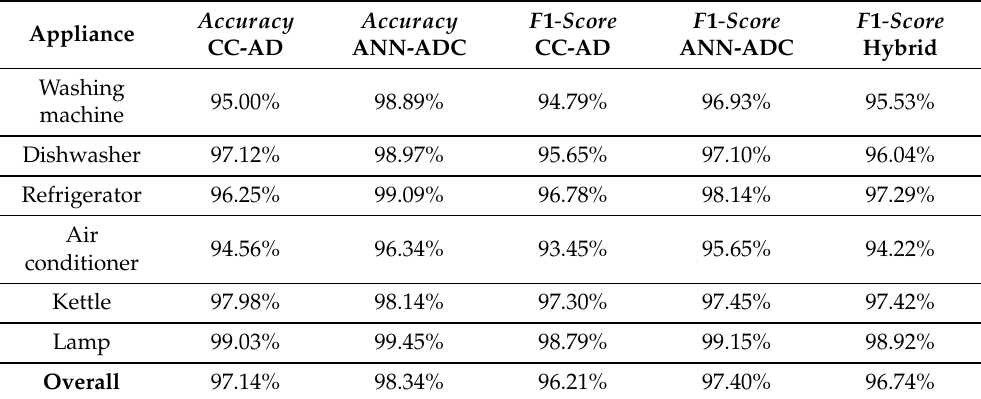
Table 4. Performance metrics of all